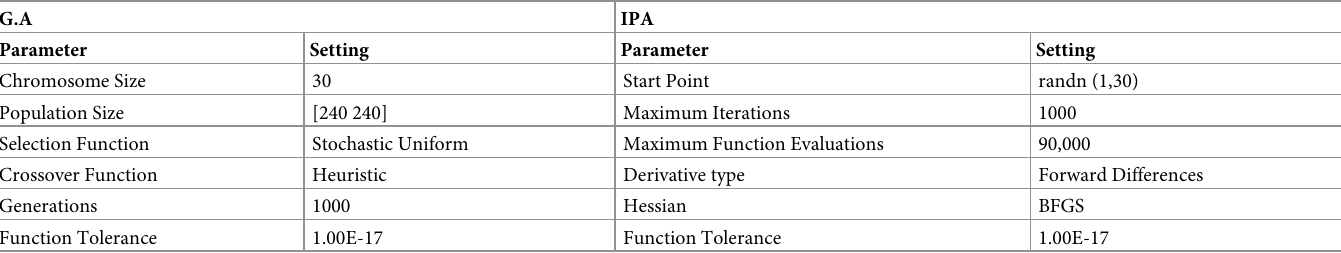
Table 2. Parameter settings.